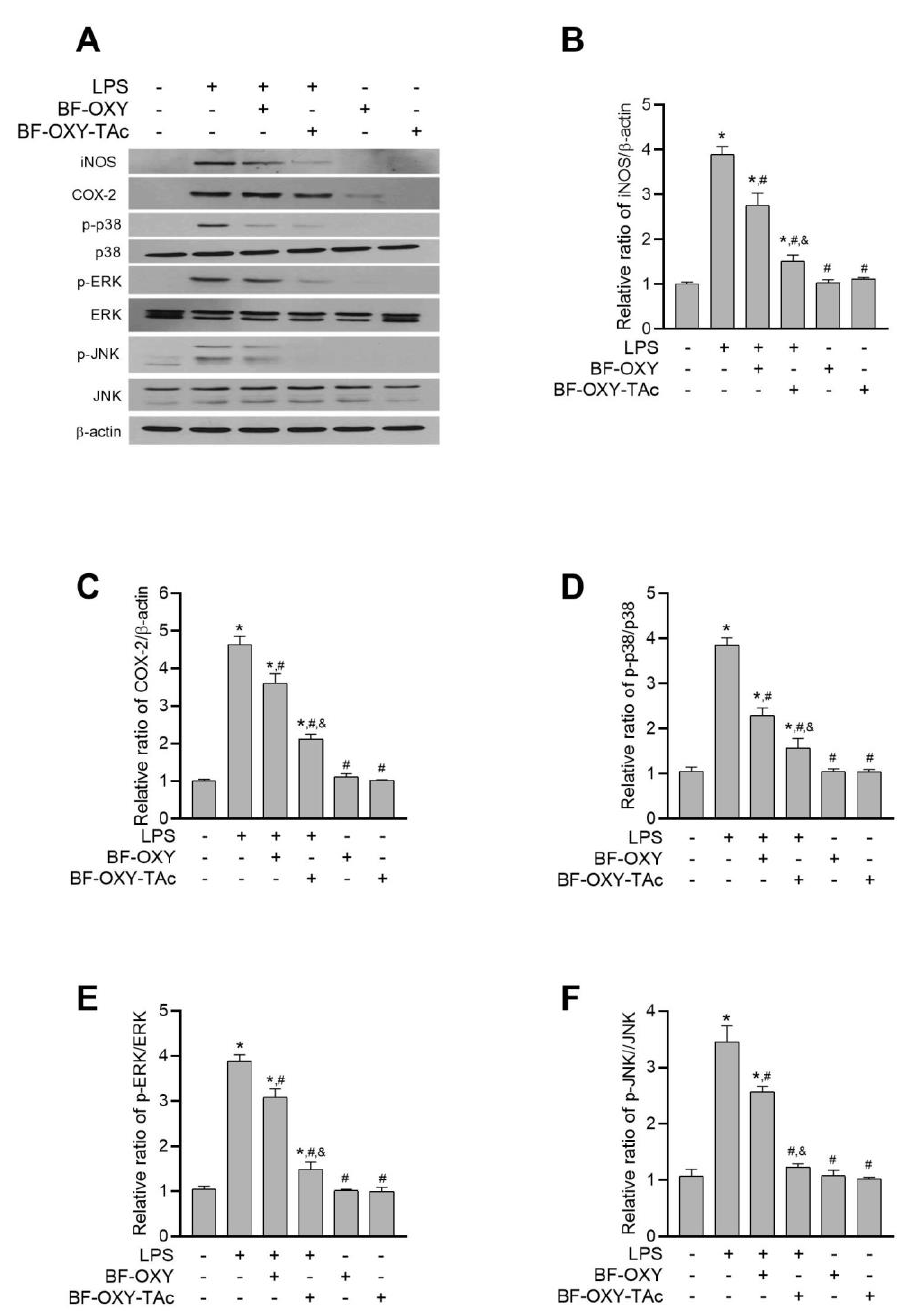
Figure 5. The effects of BF-OXY-TAc on iNOS and COX-2 and MAPK cascades in LPS-stimulated RAW264.7 cells. ( A ) The protein expressions of iNOS, COX-2, p38, ERK, and JNK were observed with western blot analysis. Results are representative of four independent experiments. ( B – F ) Band intensity of iNOS, COX-2, p38, ERK, and JNK expression was quantified. The RAW264.7 cells were pre-treated with BF-OXY or BF-OXY-TAc for 1 h before being induced with LPS (1 µg/mL) for 24 h. The data are expressed as the mean of four replicates ± SD. * p < 0.05, vs. untreated control; # p < 0.05, vs. LPS; & p < 0.05, vs. LPS and BF-OXY treated group .